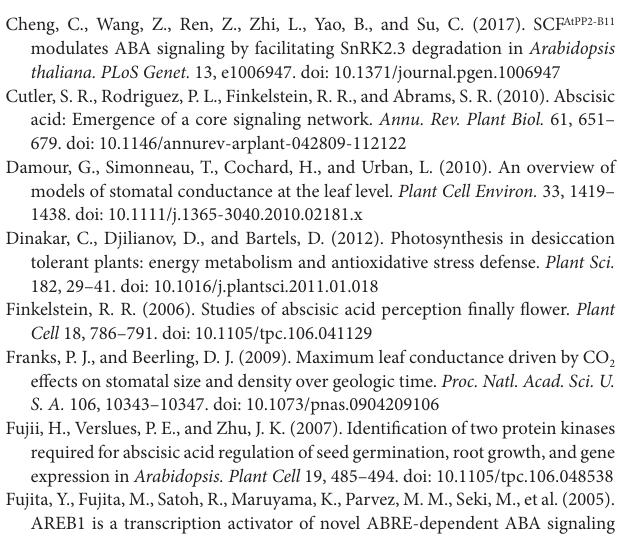
FIGURE S1 | Confirmation of TaFBA1 transgenic lines by RT-PCR. (A) RT-PCR of TaFBA1 overexpression in Arabidopsis thaliana lines and (B) TaFBA1 homozygous gene mutant recovery lines. FIGURE S2 | ABA levels in WT, TaFBA1-overexpression (OE4, OE5, OE6) and mutant ( atfbw2-4 , atfbw2-5, atfbw2-6 ) Arabidopsis lines under drought stress. FIGURE S3 | Phenotypes of WT and recovery (R-4, R-5, R-6) grown and WT, mutant, TaFBA1 -overexpression Arabidopsis plants rehydration ability under drought stress condition. (A) Phenotypes of WT and recovery (R-4, R-5, R-6) Arabidopsis plants grown under drought stress condition. (B) WT, TaFBA1 -overexpression and (C) WT, mutant Arabidopsis plants rehydration ability under drought stress condition. FIGURE S4 | Phenotypes of WT and recovery (R-4, R-5, R-6) Arabidopsis plants after ABA treatment. FIGURE S5 | Interactions of TaFBA1 with RCAR1 were analyzed via the LCI assay. FIGURE S6 | Interactions of AtFBW2 with RCAR1 and ABI5 were analyzed via the yeast two-hybrid assay. FIGURE S7 | The oxidation resistance of CB037, TaFBA1-overexpression (OE2, OE6) and TaFBA1-RNAi (R4, R5) in wheat. (A) Phenotypes of CB037, TaFBA1 overexpression (OE2, OE6) and TaFBA1 -RNAi (R4, R5) after 10 μM methyl viologen (MV) treatment. (B) The chlorophyll and (C) MDA contents of CB037, TaFBA1 -overexpression (OE2, OE6) and TaFBA1 -RNAi (R4, R5) after 10-μmol methyl viologen (MV)